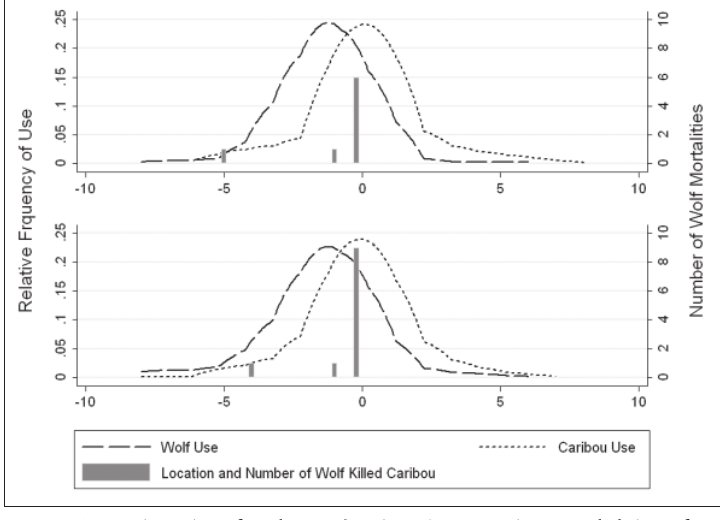
2. Seasonal overlap of caribou and wolves showing relative probability of use as a function of the difference between summer (top) and winter (bottom) caribou and wolf resource selection models, and location and frequency of caribou mortalities (black bars). Note the X axis is the difference between binned RSF values of caribou and wolves, such that high values (10) repre- sent safe areas for caribou, and low values (-10) represent high wolf use Table 1. Total area in km 2 and % of home range contained within safe zone habi- tat (with low wolf–caribou overlap) during winter and summer in the Canadian Rockies.